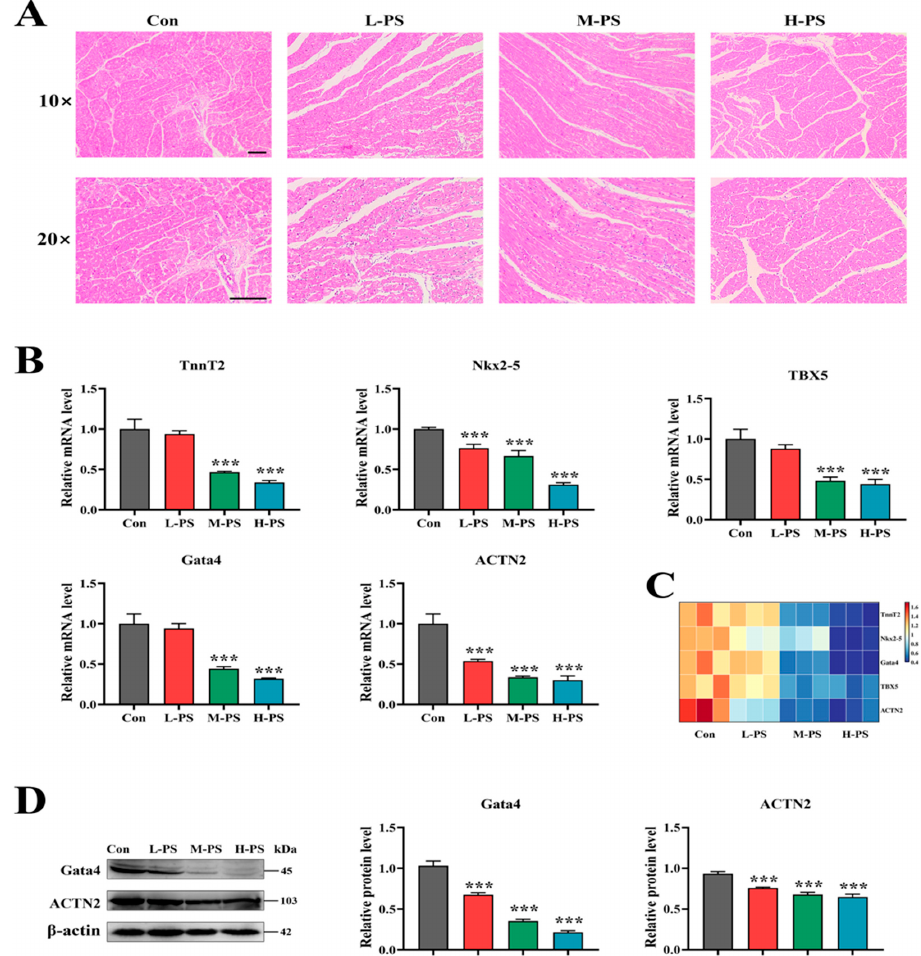
Figure 10. Effects of PS-MPs exposure on myocardial development. ( A ) Histopathological damage to the myocardium at different concentrations of PS-MPs (objective magnification of 10 × and 20 × ). ( B ) Relative mRNA expression level of TnnT2, Nkx2-5, Gata4, TBX5 and ACTN2. ( C ) Heat maps of relative mRNA expression. ( D ) Protein level of Gata4 and ACTN2. The results are presented as mean ± standard deviation (SD), compared to the control group, *** p < 0.001. Figure reproduced from Ref. [82] with permission of